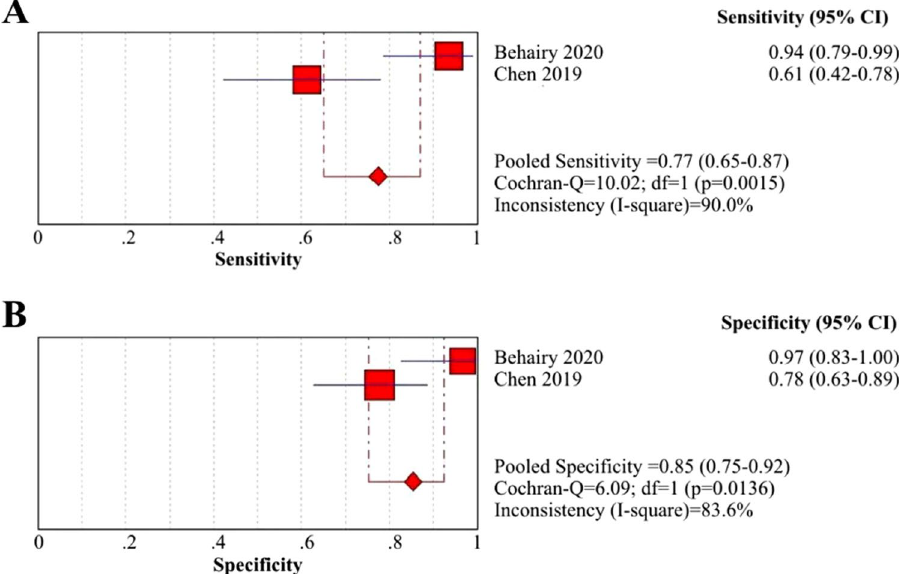
Figure 4. Coupled forest plots of the sensitivity and specificity of IL-33 for BA diagnosis. ( A ) Sensitivity of IL-33 for BA diagnosis; ( B ) Specificity of IL-33 for BA